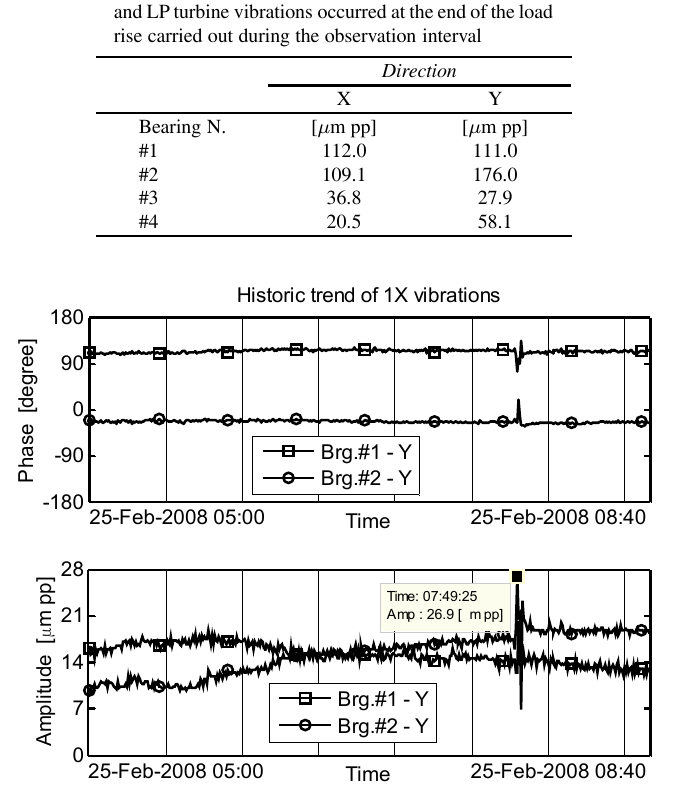
Fig. 8. Historic trend of the 1X vibrations measured on the support #2 (direction Y) at the end of a load